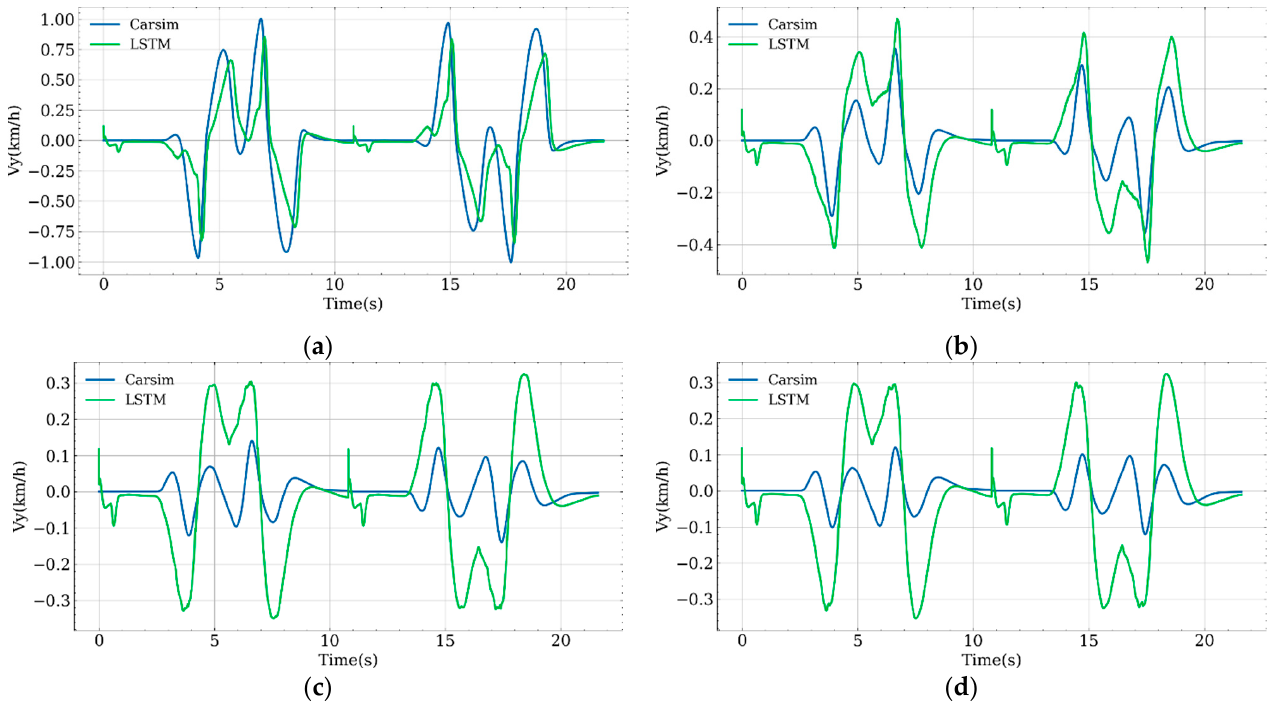
Figure 8. Estimation Results under 70 km/h DLC condition: ( a ) road friction coefficient of 0.3; ( b ) road friction coefficient of 0.5; ( c ) road friction coefficient of 0.85; ( d ) road friction coefficient of